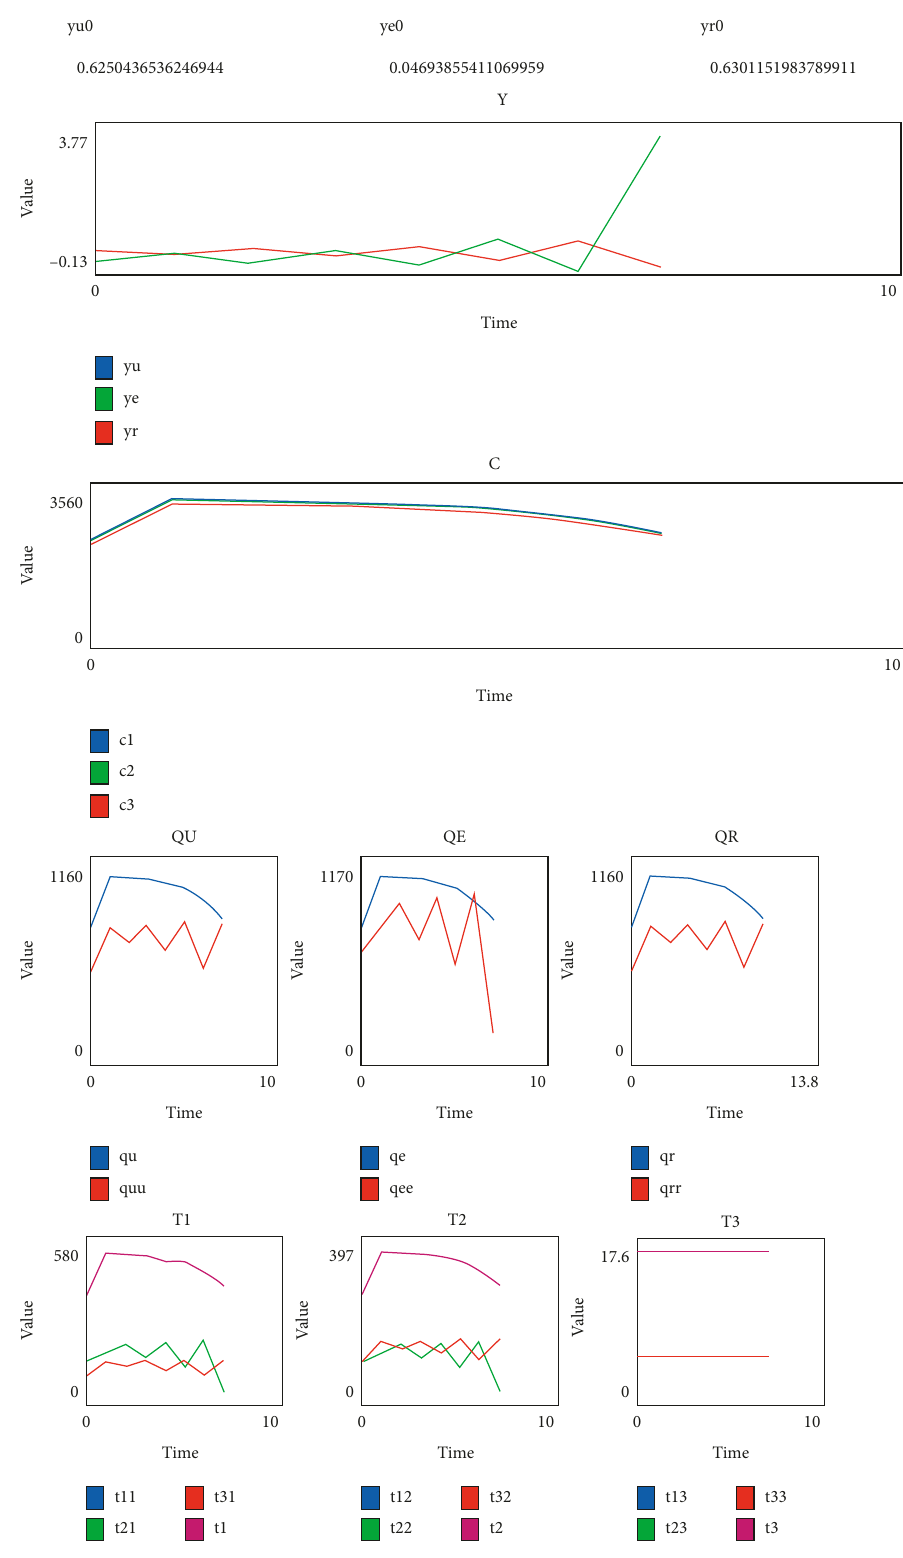
Figure 5: Simulation results of scenario